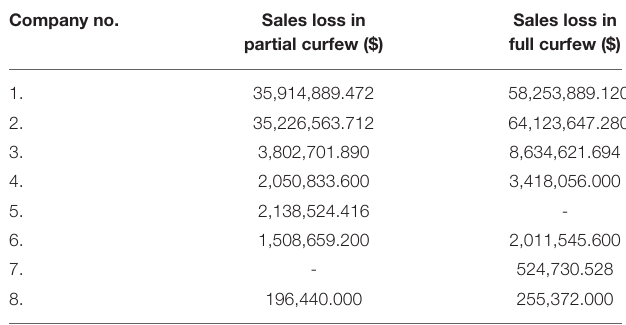
TABLE 6 | Sales loss as an effect of SARS-Con-V2 in the poultry companies in Kuwait. Company no.